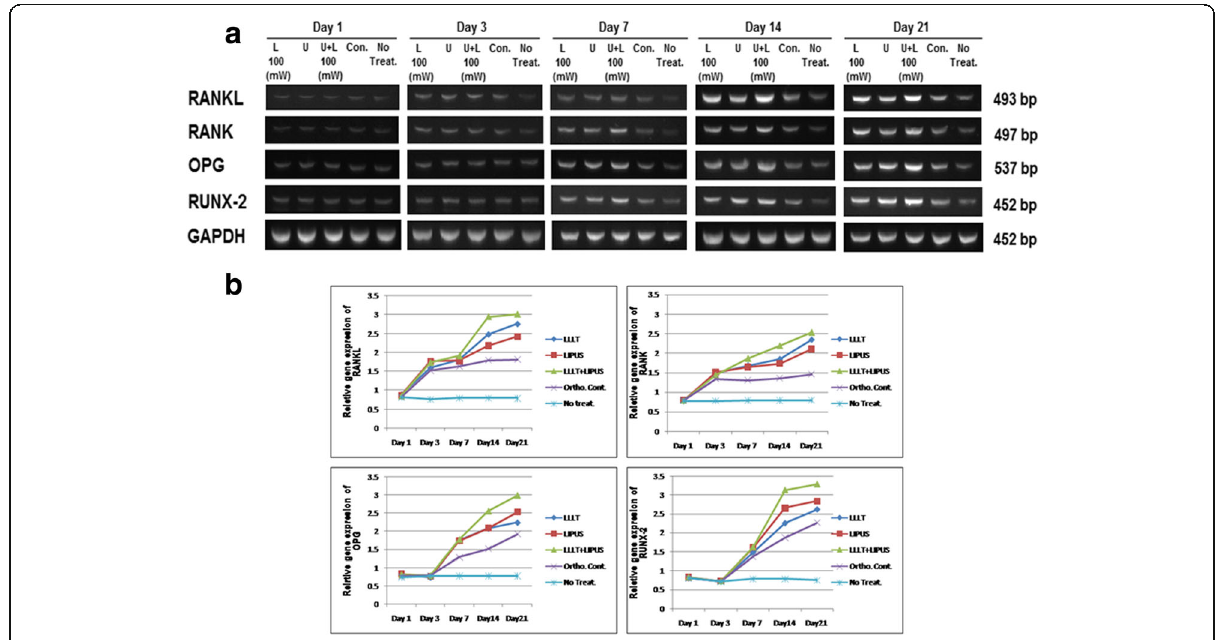
Fig. 6 Effect of LLLT, LIPUS, and combination on gene expression of rat ’ s maxilla at days 1, 3, 7, 14, and 21. The gene expression for RANKL , RANK , OPG , and RUNX2 was determined by using semi-quantitative RT-PCR and normalized by GAPDH for the following groups: non- treatment, orthodontic control, LLLT (100 mW), LIPUS, and (LLLT + LIPUS). All genes were significantly upregulated in the treatment groups in relation to the orthodontic controls. Between the treatment groups, RANKL and RANK were the highest in the combination group followed by the LLLT group. For OPG and RUNX2 , the combination group was the highest and followed by the LIPUS group. The data are shown as the mean ± SEM of three separate experiments. * P ≤ 0.05 between